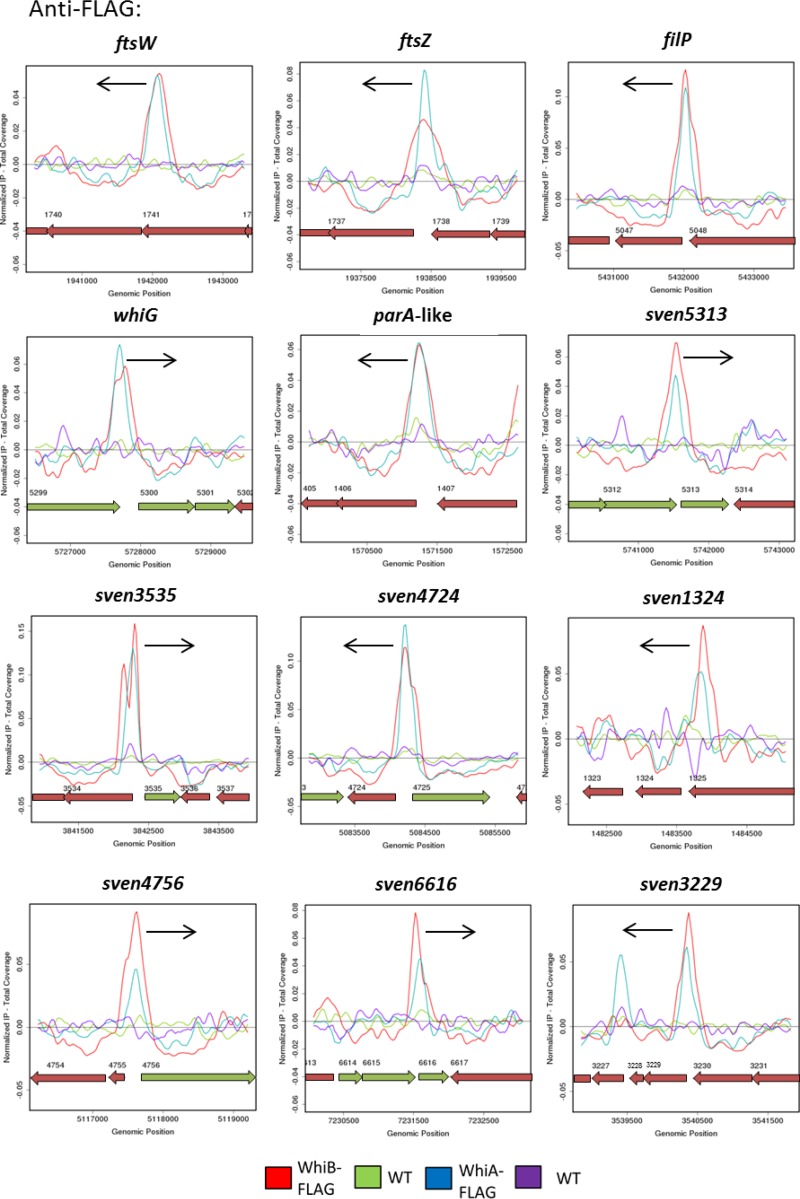
WhiA and WhiB have a shared regulon. The data compare anti-FLAG ChIP-seq results for WhiA and WhiB. ChIP traces are shown for 12 selected WhiA and WhiB target genes: ftsW, ftsZ, filP, whiG, sven1406, sven5313, sven3535, sven4724, sven1324, sven4756, sven6616, and sven3229. Color coding of the ChIP samples is as follows: 3×FLAG-[Gly4Ser]3-WhiB strain (WhiB-FLAG), red; corresponding S. venezuelae wild-type anti-FLAG negative control (WT), green; 3×FLAG-[Gly4Ser]3-WhiA strain (WhiA-FLAG), blue; and corresponding S. venezuelae wild-type anti-FLAG negative control (WT), purple. Plots span approximately 3 kb of DNA sequence. Genes running left to right are shown in green, and genes running right to left are shown in red. The black arrow indicates the gene subject to WhiA and WhiB regulation. The arrangement of the 12 panels mirrors that in Fig. 4.